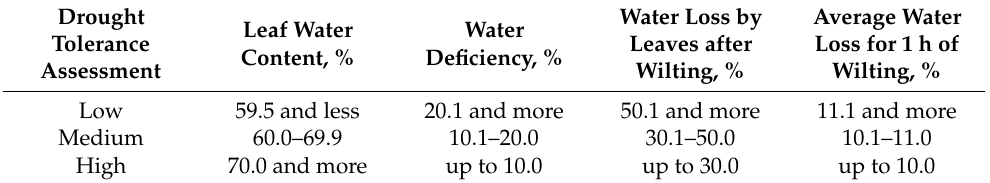
Table 2. Scale for evaluating the parameters of the water regime of leaves to determine the relative drought resistance